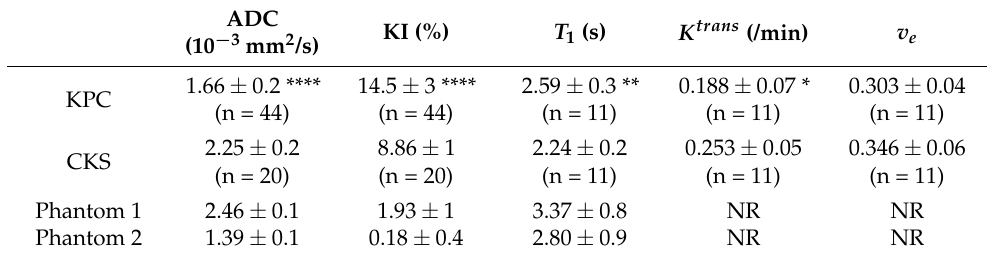
Table 2. Summary of immunohistochemistry analyses of KPC and CKS tumors a,b .